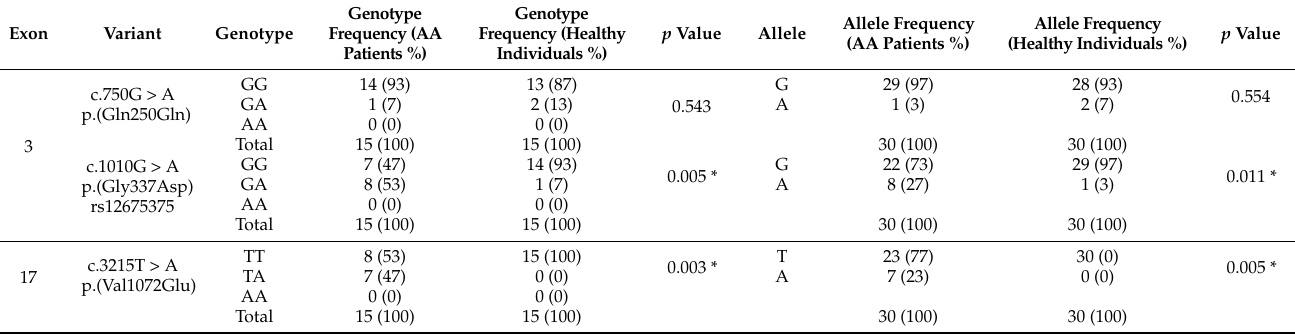
Table 2. HR gene variant